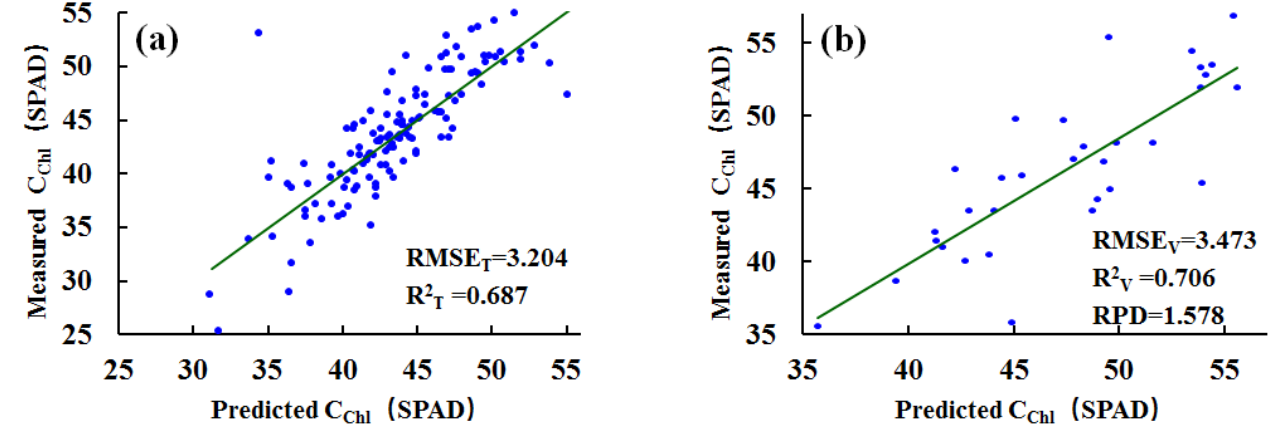
Remote Sens. 2022 , 14 , x FOR PEER REVIEW Figure 3. The estimated results of SPAD value for ( a ) training set and ( b ) validation set at jointing stage.